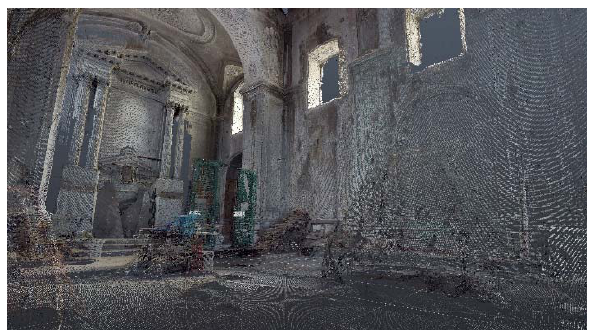
Figure 5: Matterport Pro2 3D point